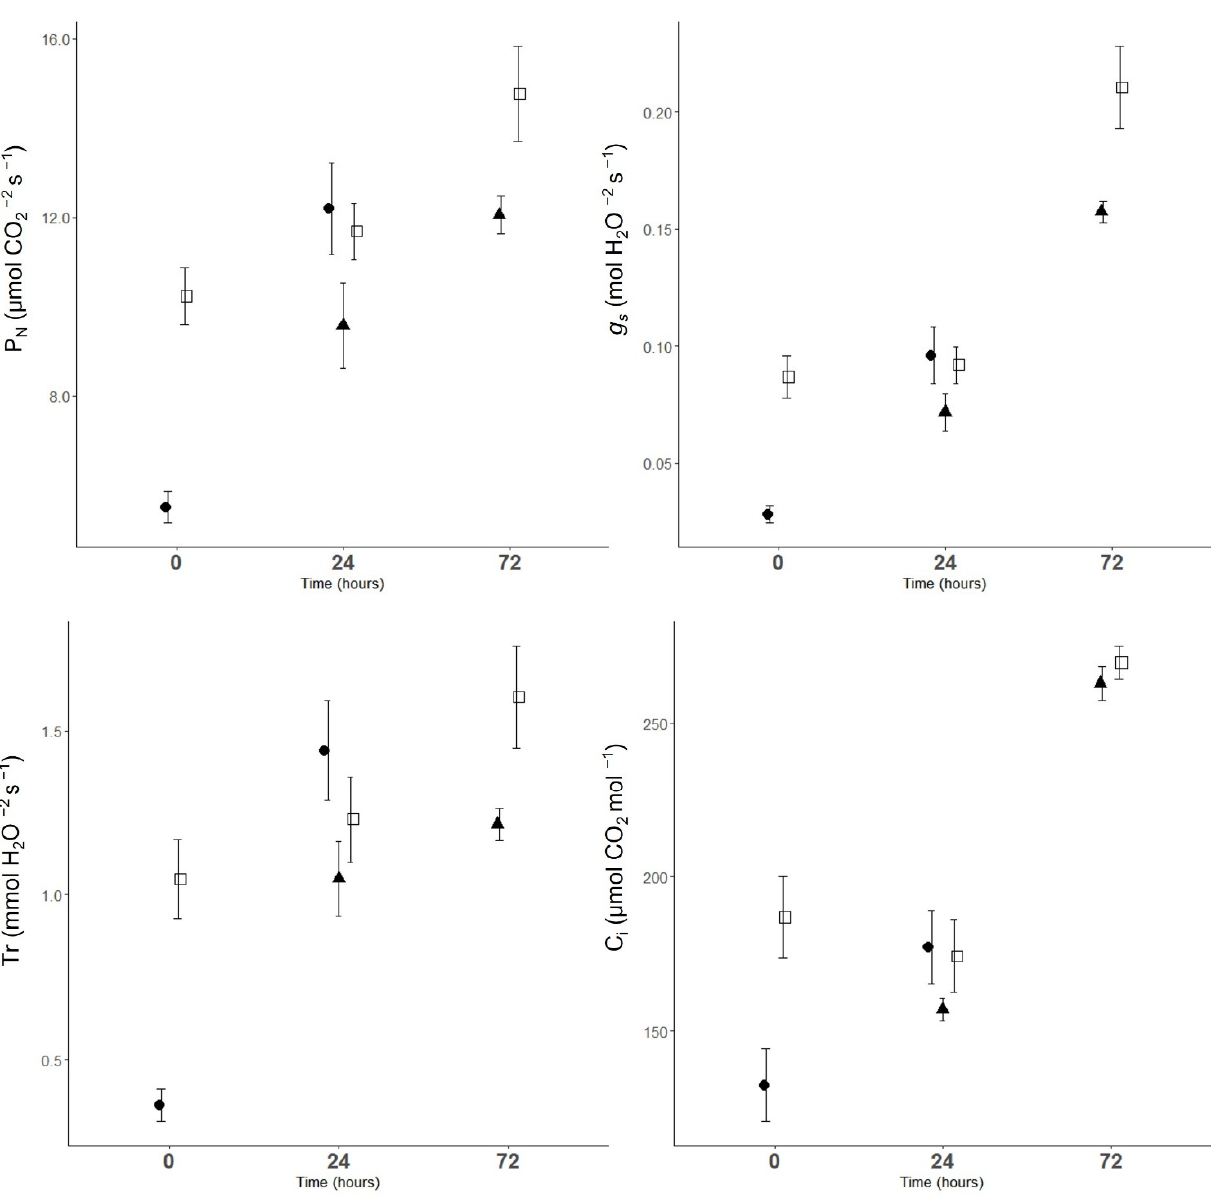
Figure 2. Net photosynthesis (P N ), stomatal conductance ( g s ), transpiration (Tr) and intercellular leaf CO 2 concentration (C i ) of sweet cherry leaf, at time 0, time 24 and time 72. ● , CT1 (one cold night exposure); ▲ , CT2 (two cold night exposures) and □ , C (control trees). Vertical bars represent ±SE of the mean ( n = 6 and 9).